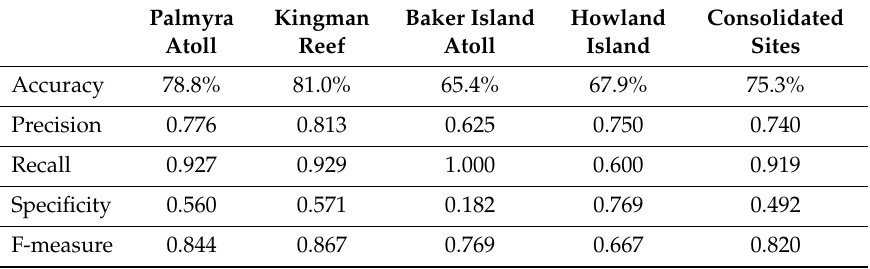
Table 5. Controlled Parameter Cross-Validation (CPCV) procedure results by site.